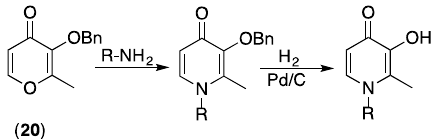
Figure 6. Structure of desferrioxamine B (DFO) and